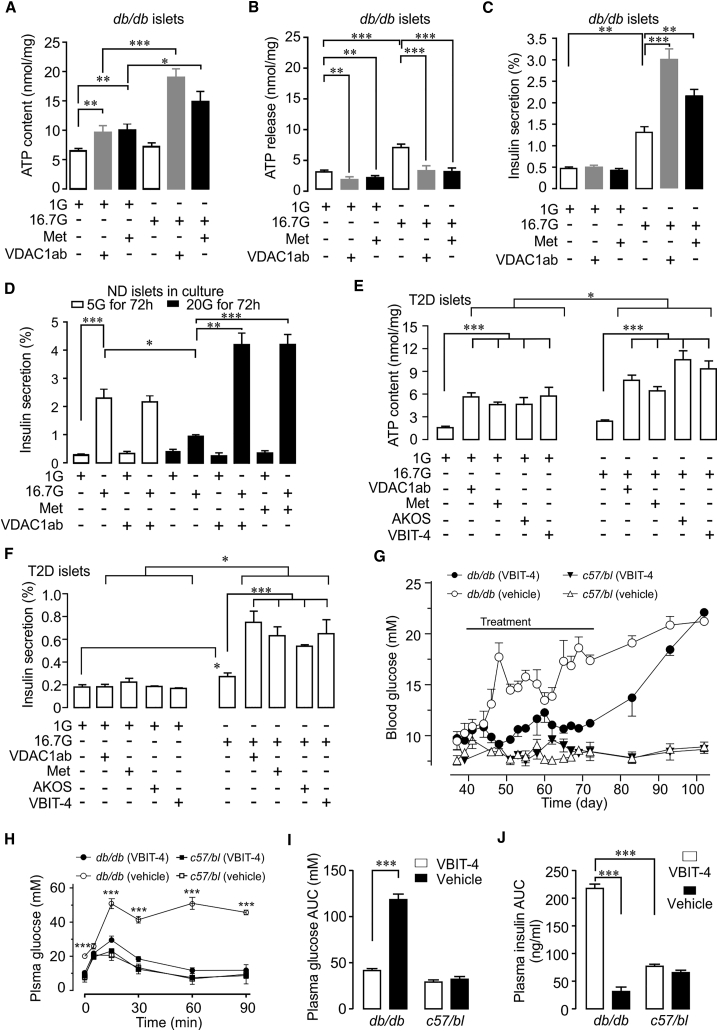
Inhibition of Cell Surface Mistargeted VDAC1 Restores GSIS in Prediabetic db/db Mice and in Human T2D Islets(A–C) One-hour exposure to VDAC1 antibody (10 nM) or metformin (20 μM) restores impaired glucose-stimulated ATP generation in islets of diabetic db/db mice in parallel with suppression of ATP release (B) and augments GSIS (C). Mean ± SEM (n = 4).(D) Insulin secretion in human ND islets cultured at 5 or 20 mM glucose (72 hr) in the presence and absence of VDAC1 antibody or metformin, followed by 1 hr incubation at 1G or 16.7G.(E) Acute addition of VDAC1 inhibitors (1 hr) improves glucose-stimulated ATP generation in islets from T2D donors.(F) Improved GSIS in the T2D islets shown in (E). Mean ± SEM (3–6 donors).(G) The VDAC1 inhibitor VBIT-4 prevents hyperglycemia in prediabetic db/db mice injected at 6 weeks (25 mg/kg daily intraperitoneally [i.p.]) compared with vehicle-treated db/db mice (n = 12). C57/bl6 mice receiving either VBIT-4 (n = 5) or vehicle (n = 6) are also depicted. Six db/db mice from each group were followed for another 3–4 weeks for reversibility of the treatment. All C57/bl6 mice were monitored throughout. Note the gradual increase and long duration before reaching full hyperglycemia after VBIT-4 cessation.(H) Plasma glucose concentrations during intraperitoneal glucose tolerance test (2 g/kg) in db/db or C57/bl6 mice after VBIT-4 treatment as in (G). Mean ± SEM of 12 mice (12 db/db and 5–6 C57/bl6 in each group).(I) AUC for plasma glucose.(J) AUC for plasma insulin (for plasma insulin values, see Figure S7J).